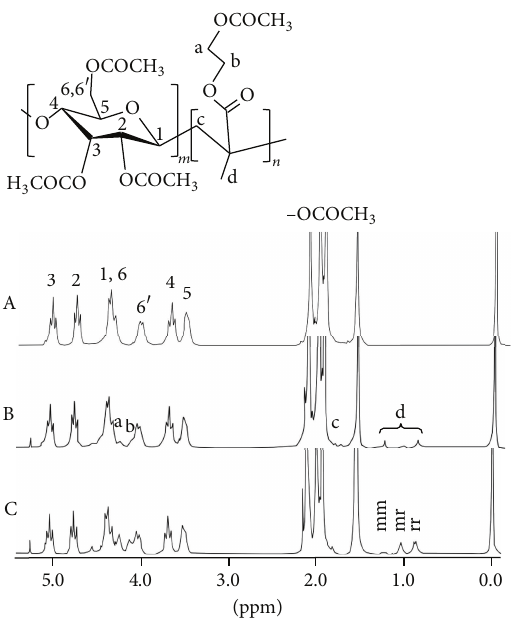
1 H-NMR spectra of the acetylated MCC (A) as control and acetylated MCC-block-pHEMA produced by mechanochemi- cal polymerization for (B) 1h and (C)